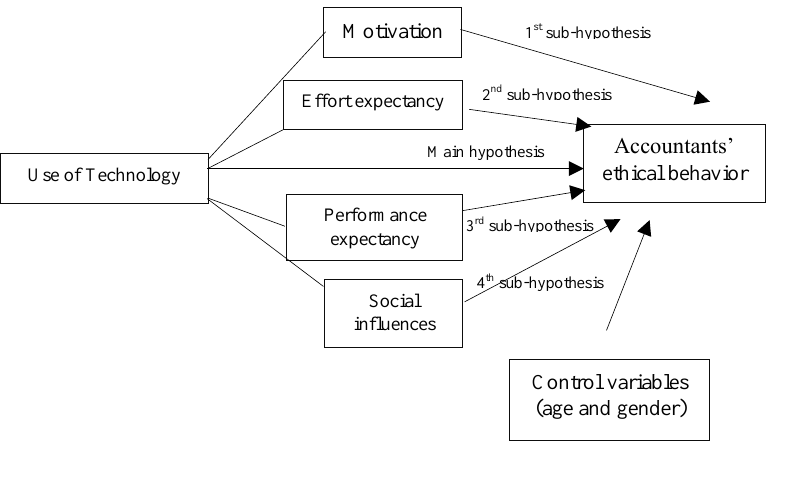
Fig. 1. Conceptual research